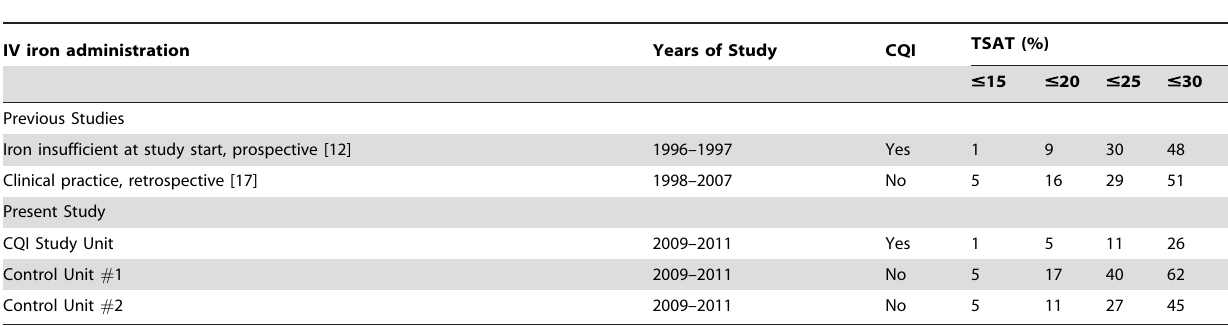
Table 3. Percentage of patients with various TSAT levels in the last 3 months of three studies over 14 years from 1997 to 2011.